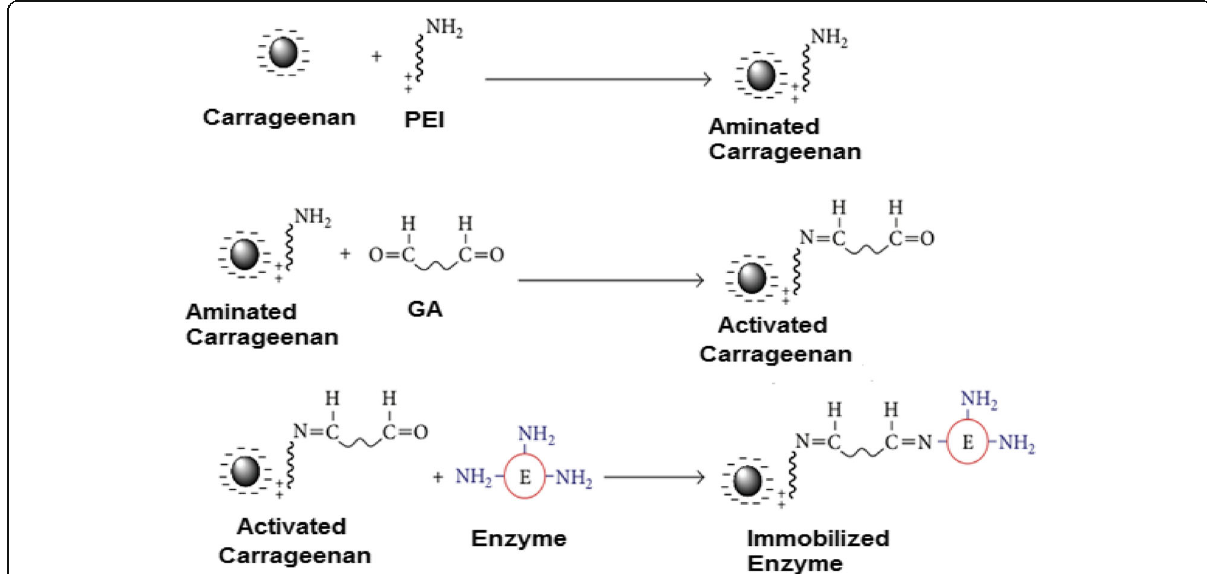
Fig. 1 Schematic representation of carrageenan gel beads activation and enzyme